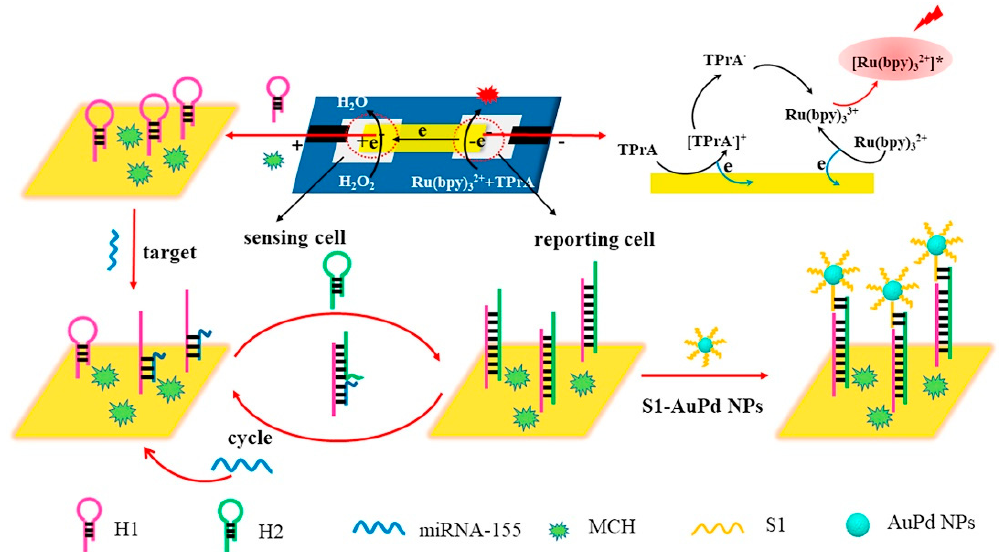
Figure 10. Scheme of ECL biosensor development for the detection of miRNA-155 using a microfluidic system based on a paper-based closed Au-bipolar electrode proposed by Yu et al. [166] . Reproduced and adapted with permission of Elsevier.